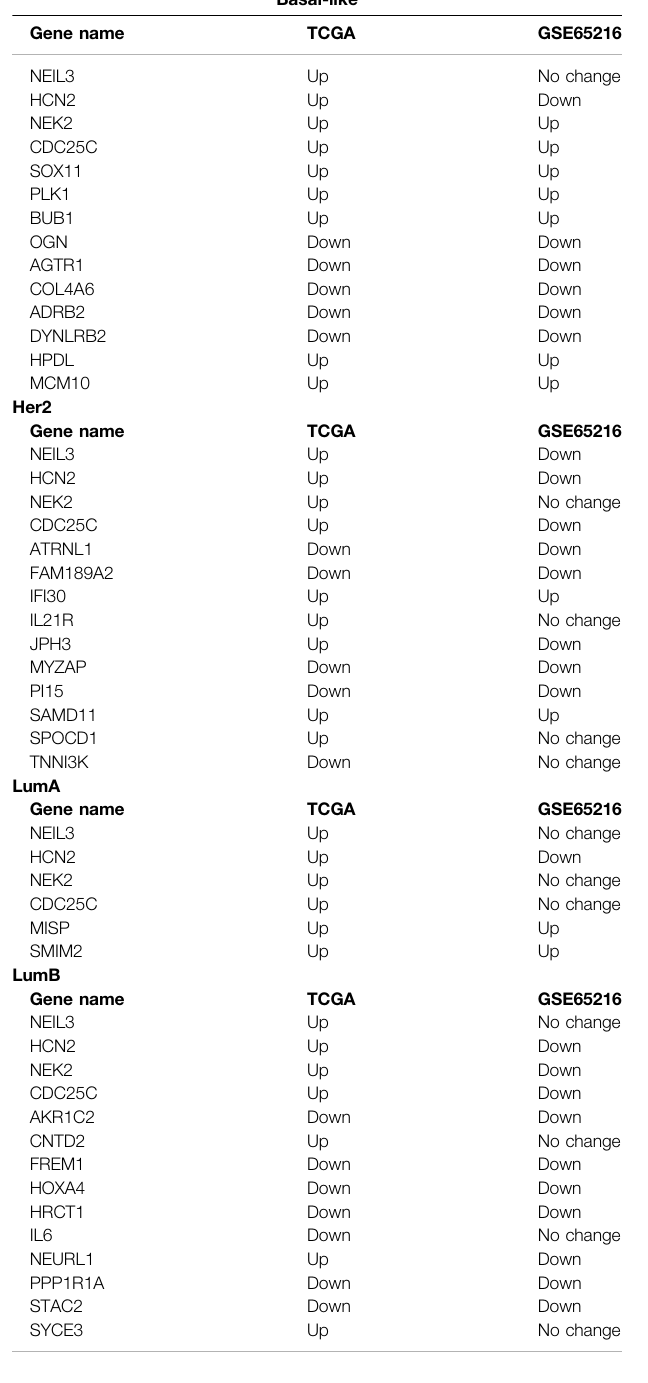
TABLE 3 | The key common and speci fi c DEGs selected were veri fi ed in the GSE65216 dataset.